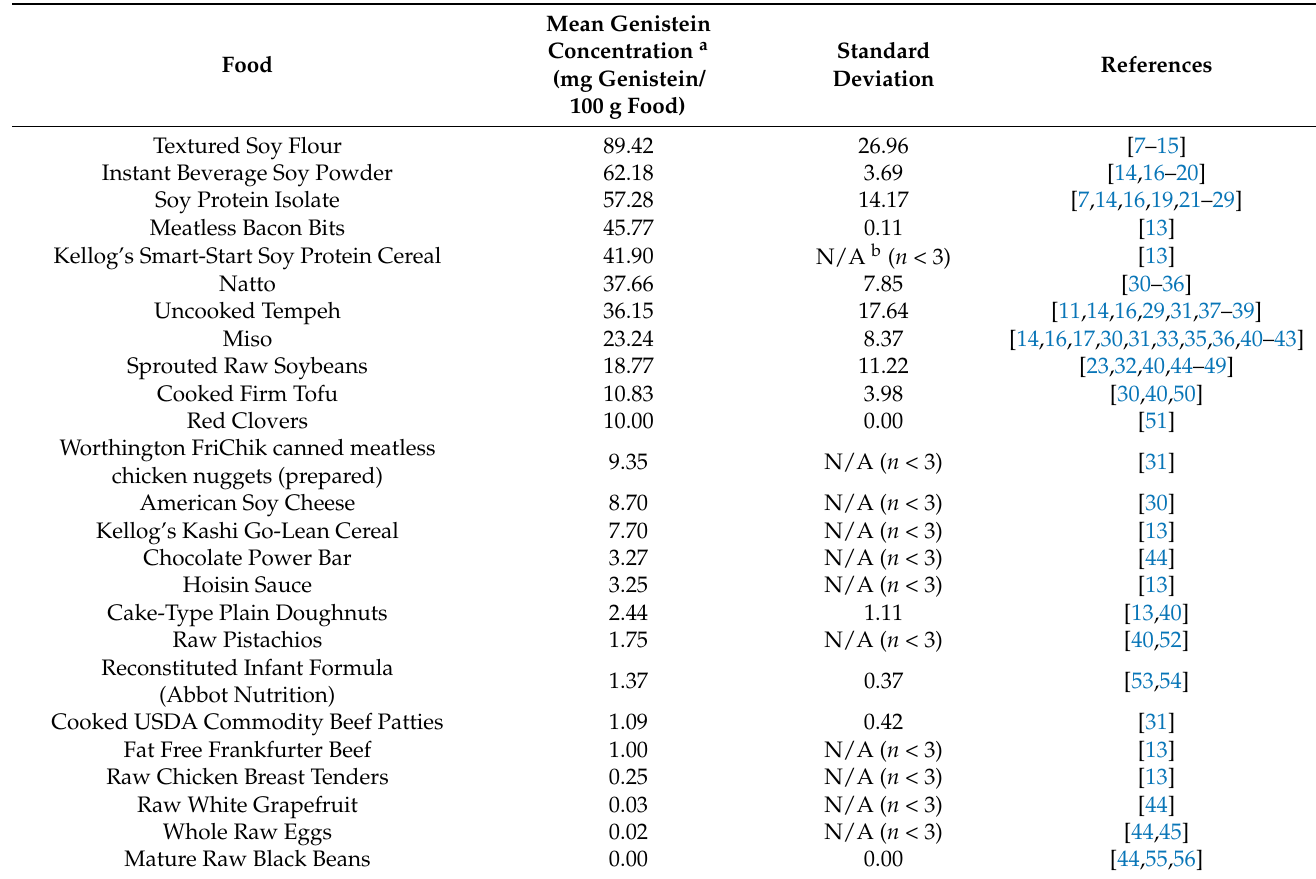
Table 1. Genistein content in consumable products.